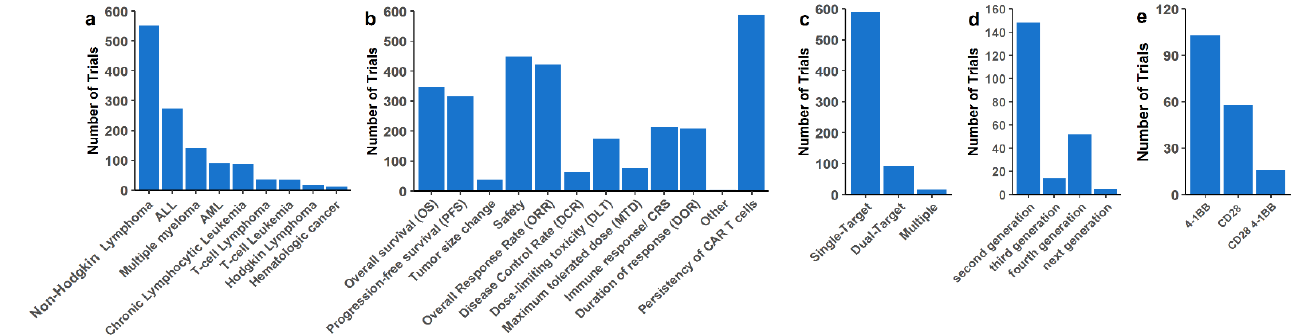
Figure 2. CAR-T cell strategy for hematological malignancies under clinical trial evaluation. ( a ) Hematological malignancies treated by CAR-T cells under clinical trials (non-Hodgkin’s lymphomas including DLBCL, MCL, Follicular lymphoma, mediastinal large B cell lymphoma, B cell lymphoma, CLL, and Small Lymphocytic Lymphoma). ( b ) Primary and secondary endpoints of clinical trials. All endpoints for a given trial are presented in this graph. ( c ) Number of simultaneous targets by one CAR or combination of different CAR-T cells delivered at once or in sequence for the patients. Multiple includes three or more targets at once. Several targets for multiple patients were considered as single-target therapy. ( d ) CAR generation used in clinical trials. ( e ) Number of clinical trials with CD28 and/or 4-1BB costimulatory signal on CAR constructs.